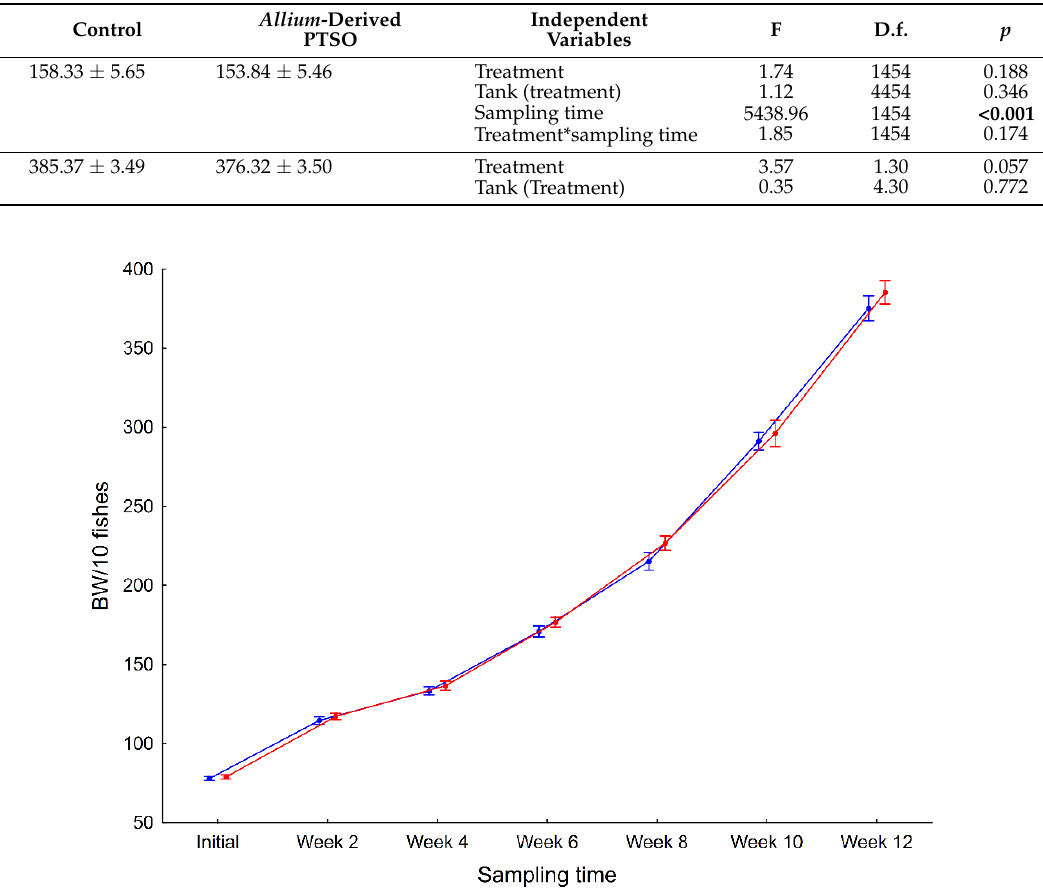
Figure 5. Body weight (g) of control (red) and Allium-derived PTSO (blue) supplemented gilthead Figure 5 . Body weight (g) of control and Allium-derived PTSO supplemented gilthead bream juve- bream juveniles during the 12 weeks experiment. Whiskers show ± 95% confidence niles during the 12 weeks experiment. Whiskers show ± 95% confidence intervals.